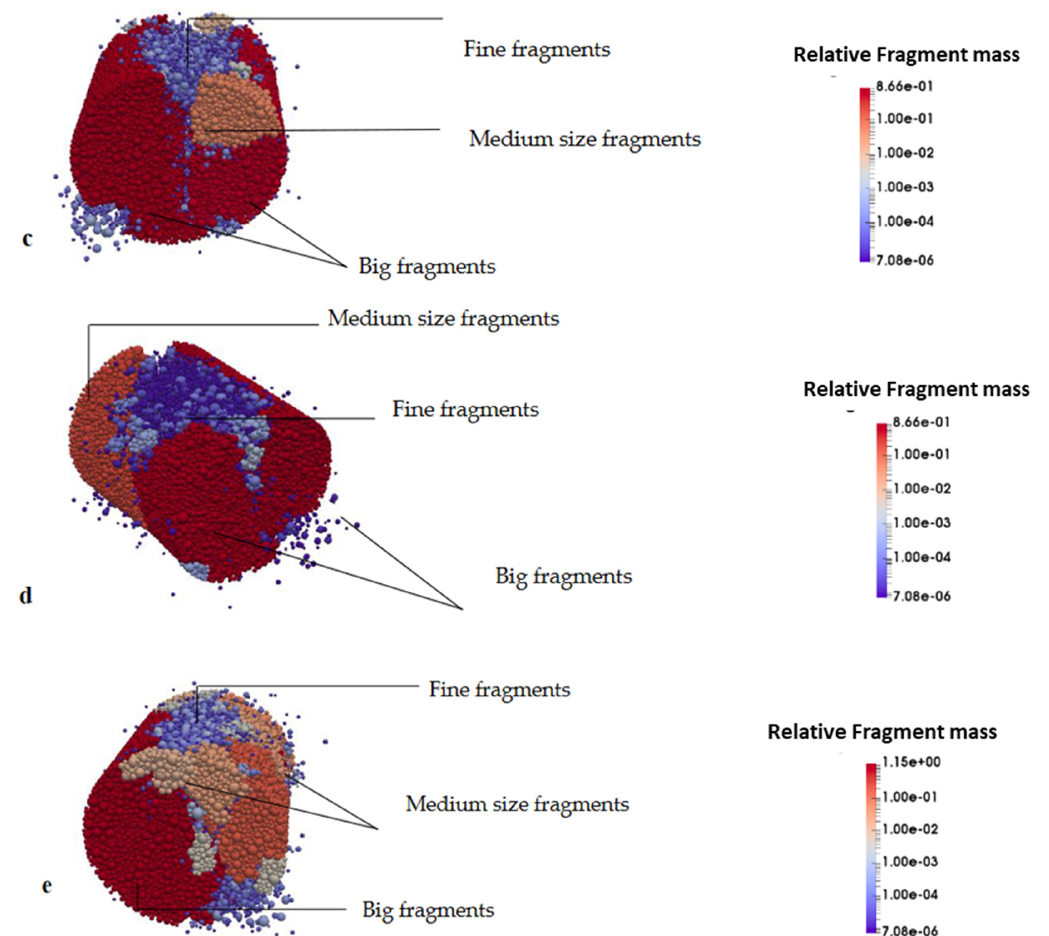
Figure 14. Ranges of fragments generated at the different crack levels. ( a ) fine and big fragments at 0 crack, ( b ) fine and big fragments at 30 cracks, ( c ) fine, medium size and big fragments at 90 cracks, ( d ) fine, medium size and big fragments at 180 cracks, ( e ) fine, medium size and big fragments at 300 cracks. In each case, the relative fragment mass is the of fragment mass relative to the original specimen.